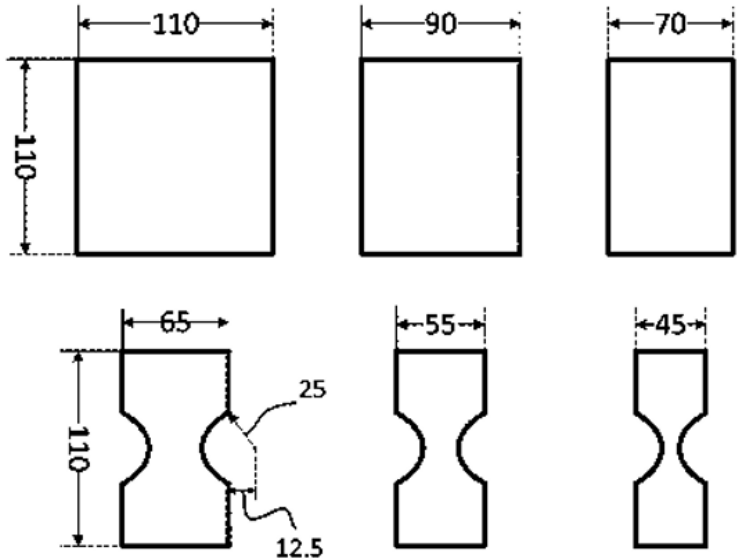
Figure 1. Primary geometry of the samples for the Nakazima test (all dimensions are in mm). This maximum punch velocity was 200 mm/min, and it was adjusted at 20, 100, 200 mm/min for our tests. Tensile and pressure loadings awee both possible using this machine by controlling speed and force. It was also possible to control the process manu- ally and digitally at any time using the machine monitoring system. The force diagram decreased sharply when necking happened, so that the testing stopped. The uniaxial tensile test was performed according to the standard of ASTM-B557M to obtain the gen- eral mechanical properties. The sheet’s mechanical and physical properties are shown in Table